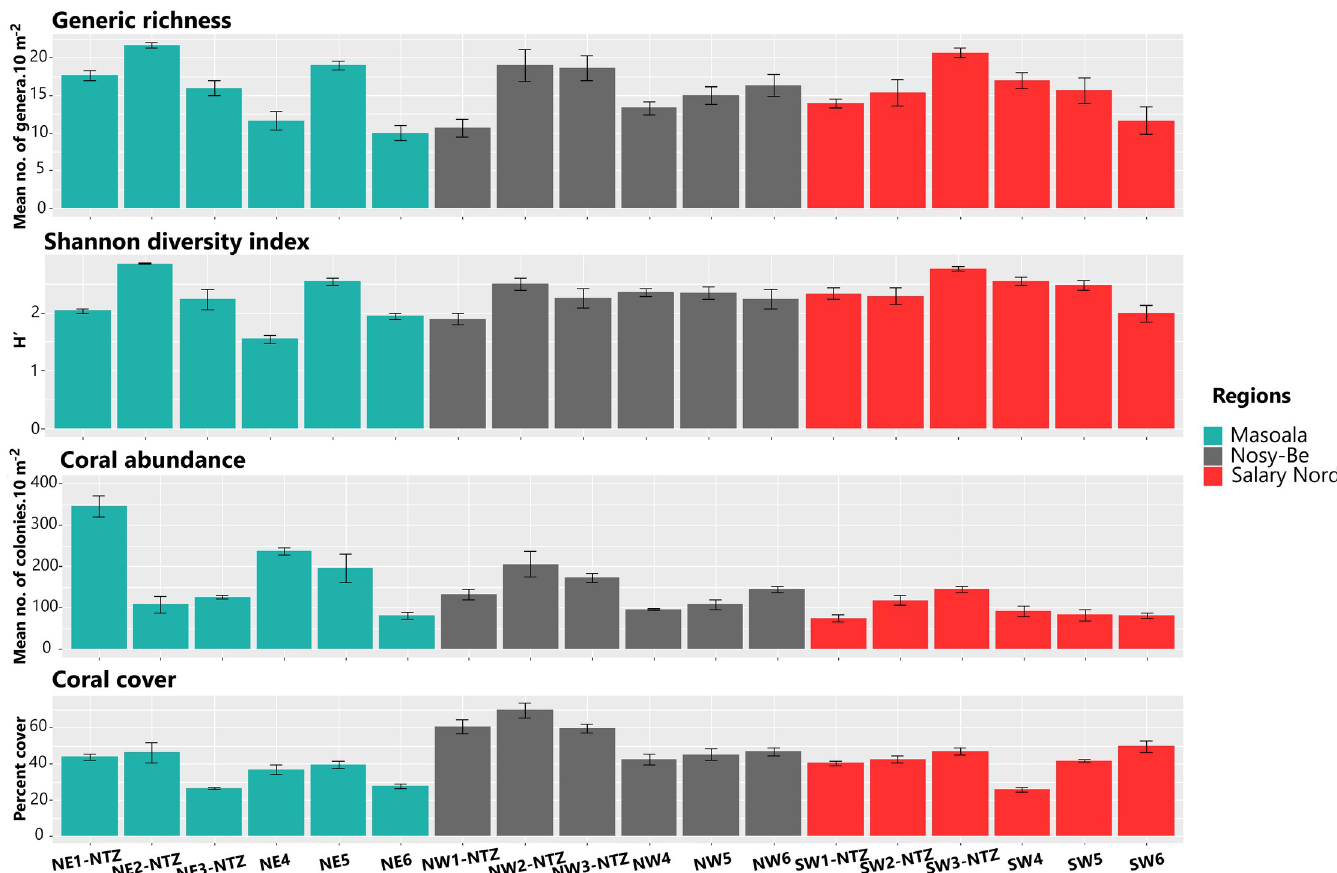
Fig 4. Spatial variation in generic richness, Shannon diversity index, abundance, and percent cover of coral assemblages. Data are given for the 18 sampling stations located at the three regions. Errors bars represent standard error.